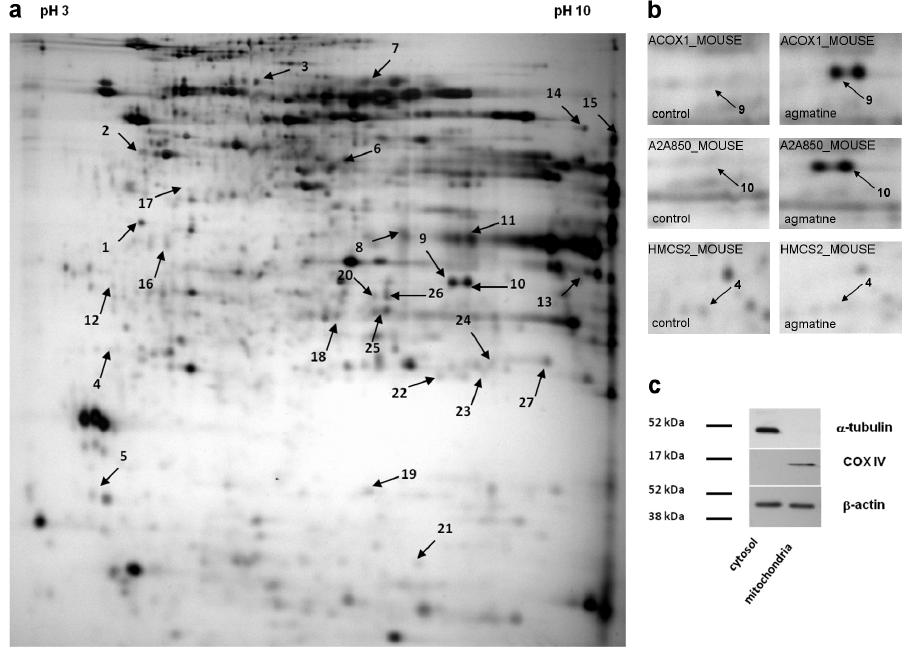
Figure 4. Representative 2D map of mitochondrial proteins expressed in apoE-knockout mice ( a ), with magnifications of spot pairs corresponding to peroxisomal acyl-Coenzyme A oxidase 1 (ACOX1), acyl-Coenzyme A oxidase 1, palmitoyl (A2A850), and hydroxymethylglutaryl-CoA synthase (HMCS2) ( b ). The arrows mark 27 spots showing differences between control and agmatine-treated group (spot numbers correspond to the numbers in Table 5). Purity of mitochondrial fraction was assessed by the Western blotting method, showing the absence of cytosolic a-tubulin l in mitochondrial fraction ( c ).